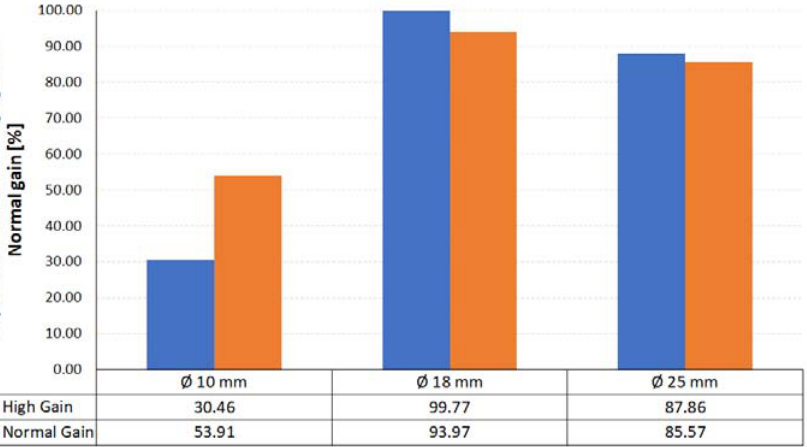
Figure 7. Diameter value improvements in non-contact measurement with medium and high gain in all three diameters.